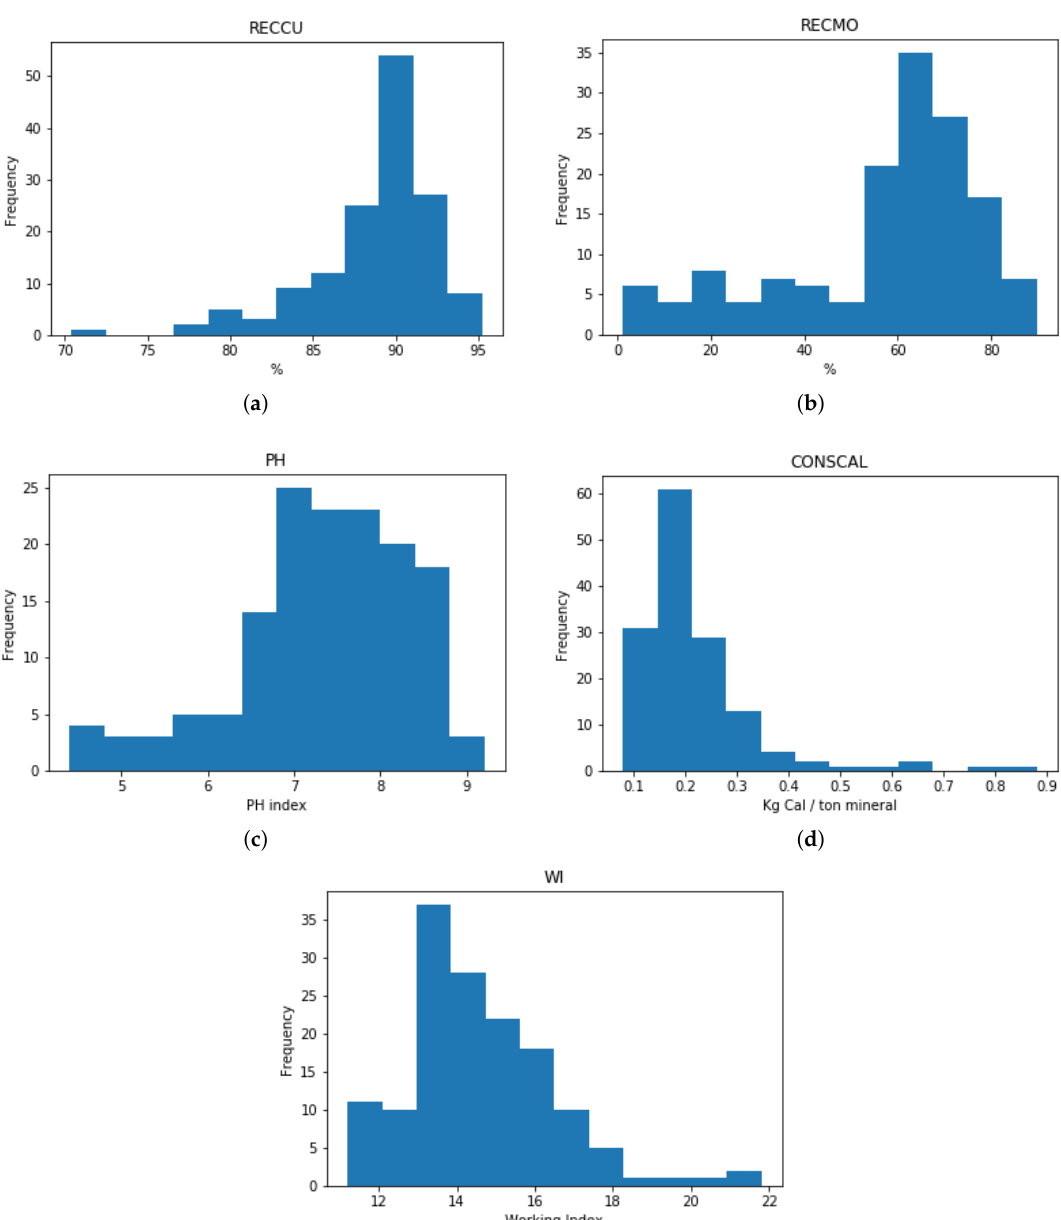
Figure 13. Histograms of the measured variables. Distribution and dynamic ranges for: ( a ) recovery of copper, ( b ) recovery of molybdenum, ( c ) PH of the sample, ( d ) consumption of calcium carbonate and ( e ) bond working